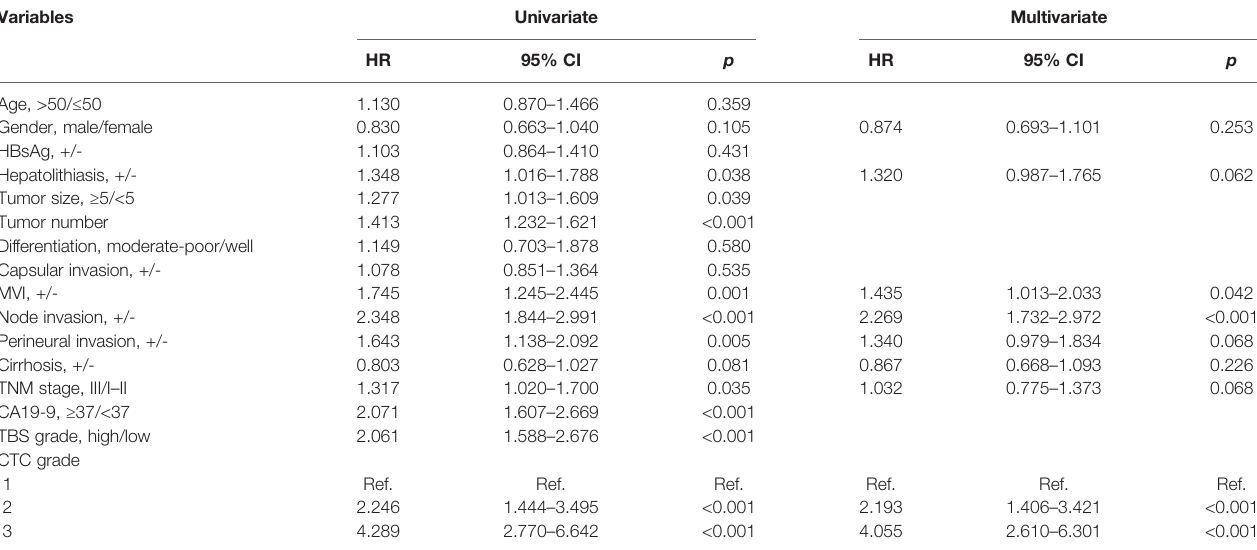
TABLE 3 | Cox regression analysis for OS of ICC patients in the derivation cohort.